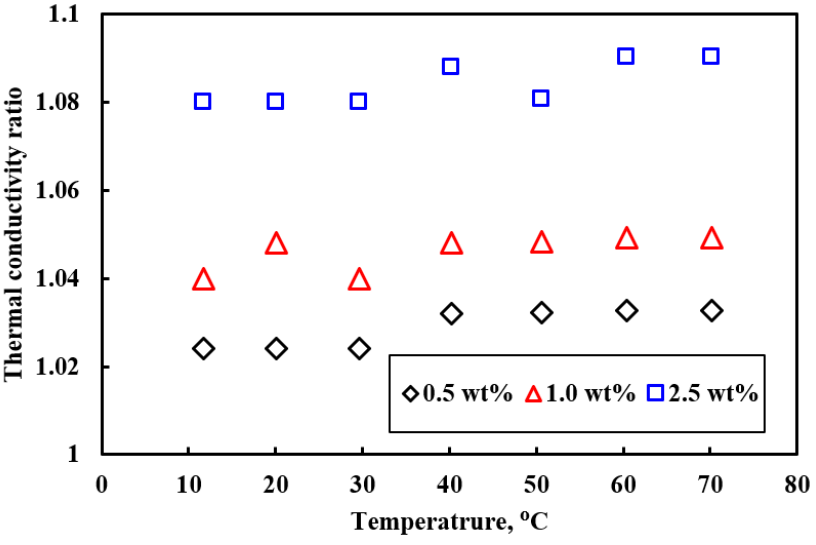
Figure 12. Thermal conductivity ratio of Al 2 O 3 nanoparticles enhanced[C 4 mmim][NTf 2 ] IL[62]. Reproduced with permission from [Paul], [. Appl. Therm. Eng.]; published by [Elsevier], 2017.